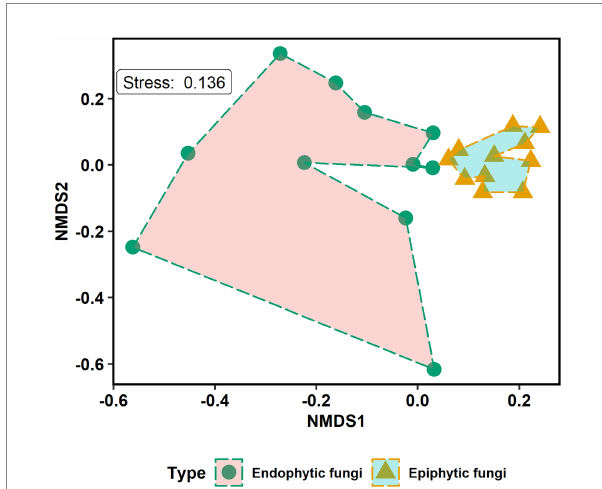
FIGURE 3 Non-metric multidimensional scaling (NMDS) ordination plot of the community composition of epiphytic and endophytic fungi in mangrove species. The endophytic and epiphytic fungi are grouped by fungal types. Kruskal’s stress value equals